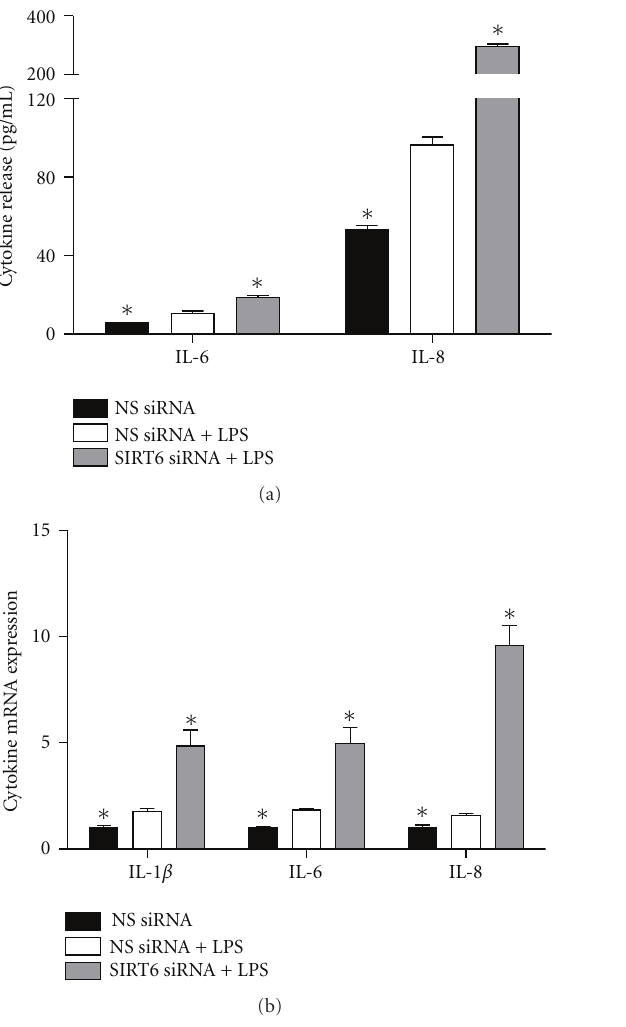
Figure 4: E ff ect of SIRT6 knockdown on COX-prostaglandin pathway. HUVECs were transfected with 50 nM SIRT6 or NS siRNA for 72h followed by 10 μ g/mL LPS for 24 h ( n = 6). (a) COX-1 and COX-2 mRNA expression was quantified by qRT-PCR. (b) PGE 2 and PGF 2 α levels in the conditioned media was assayed using EIA. Each bar represents the mean ± SEM. ∗ P < 0 . 05 versus NS siRNA +